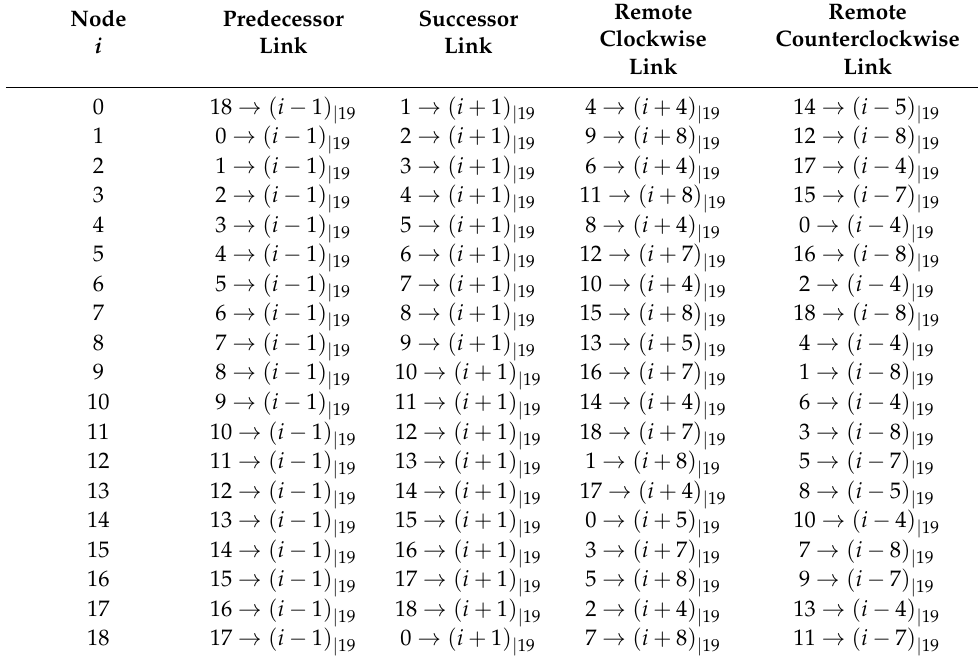
Table 6. Link destination for the nodes within a Robertson